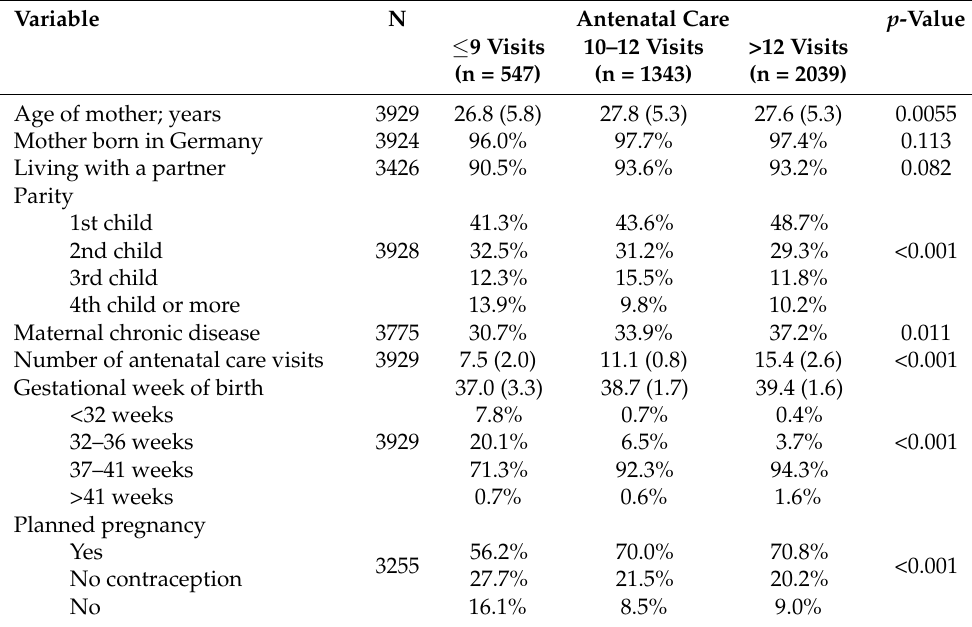
Table 1. Maternal and pregnancy characteristics stratified by the participation in medical check-up during pregnancy in the SNiP-I cohort from 2004 to